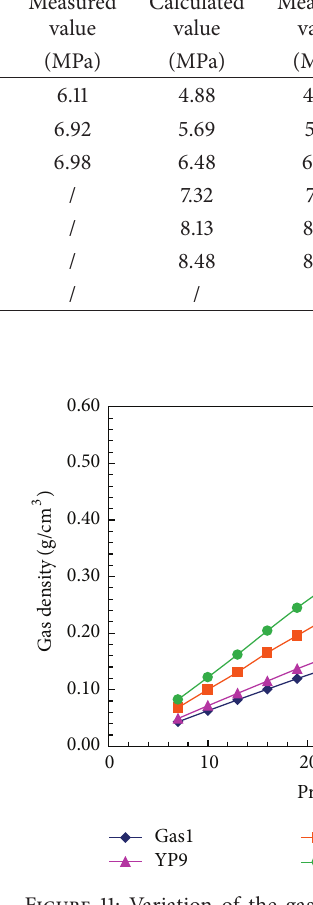
Figure 9: Variation of the relative volume of different CO 2 content natural gas samples with pressure at 127.5 ∘ C.